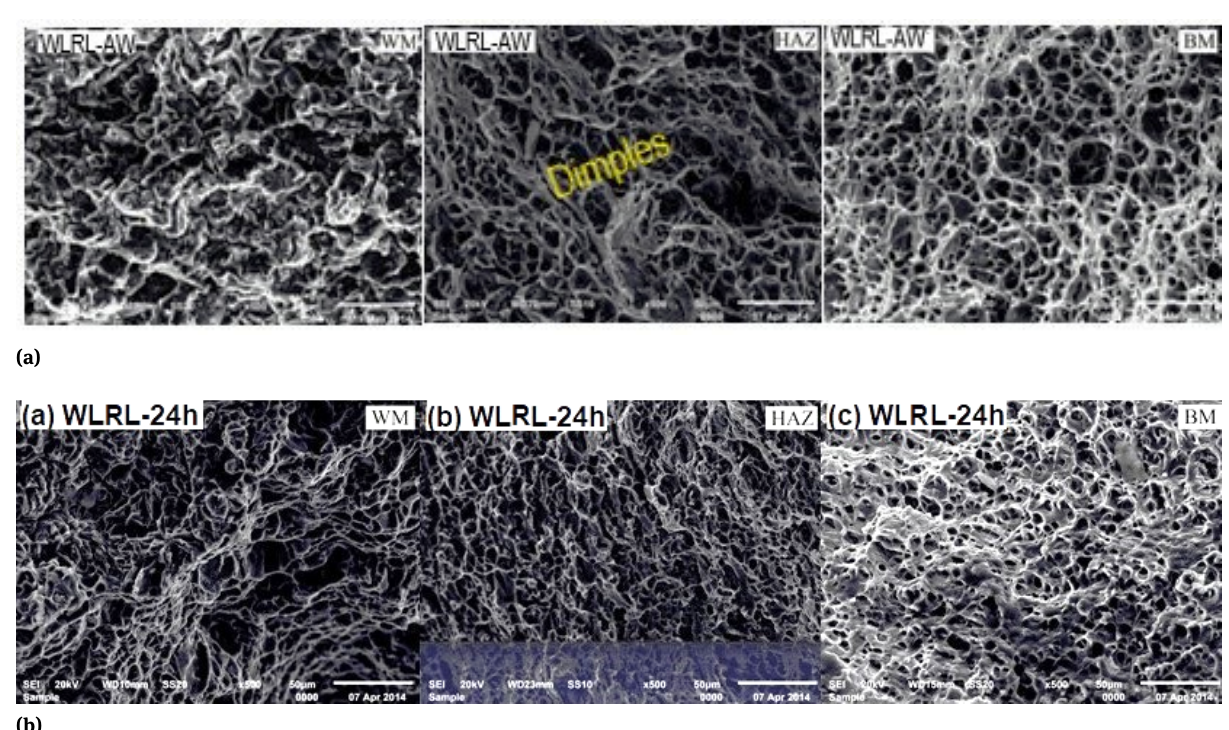
Figure 12: Typical SEM fractographs of; (a) As-welded AL6061, and (b) AL6061-T6 aged for 24 hours on WLRL specimen, indicating WM, HAZ, and BM (left to